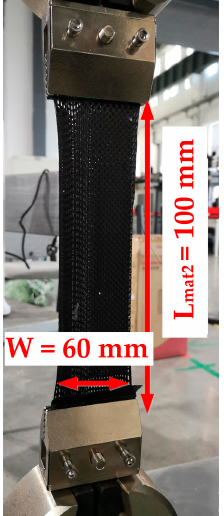
Figure 7. Size of the axial tensile material.